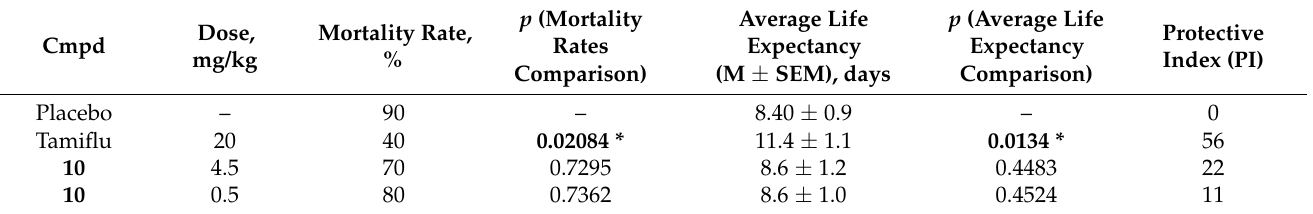
Figure 2. Dynamics of changes in body weight of BALB/c mice with experimental influenza pneumonia upon infection with influenza A/California/7/09/MA virus (N = 10). Infection with the IAV strain A/California/7/09/MA caused mouse mortality starting from day 5 post infection (p.i.). By the end of the experiment, mortality was 90% in the Placebo group and 40% ( p = 0.015) in the comparison group (Tamiflu), which corre-